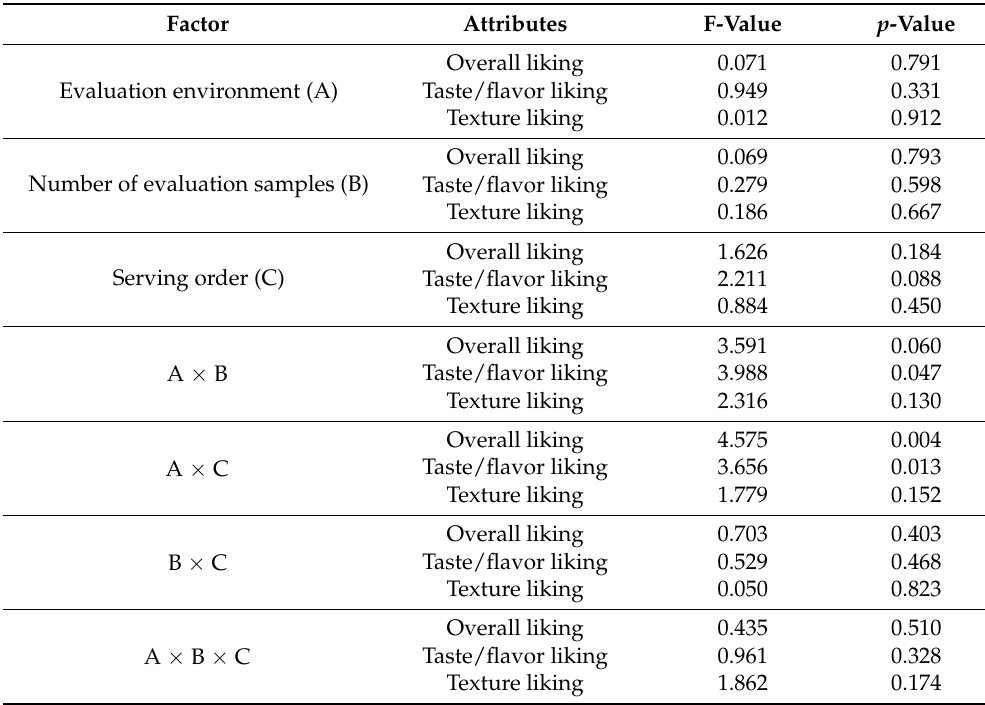
Table 5. Effect of the evaluation environment, the number of evaluation samples and the serving order on the liking ratings for the two-sample and four-sample conditions of the almond beverage test target